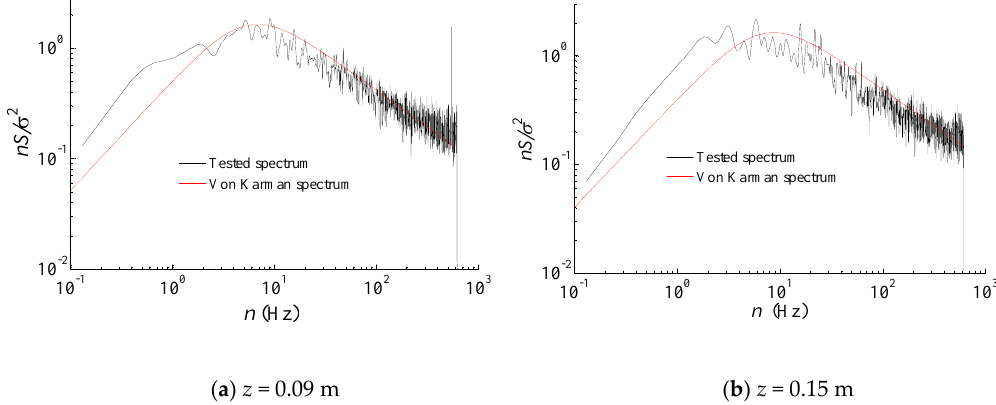
Figure 4. Tested wind power spectra and von Karman spectrum.